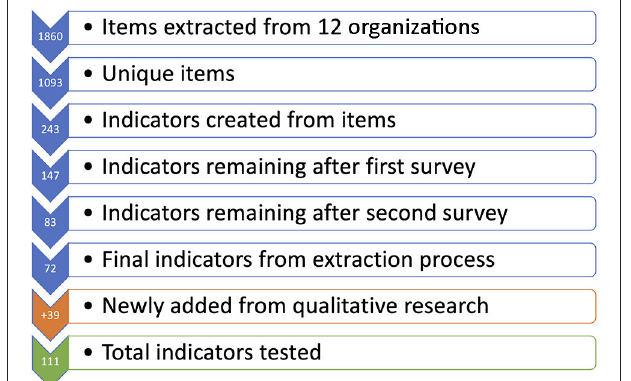
FIGURE 2 | Indicator reduction process.